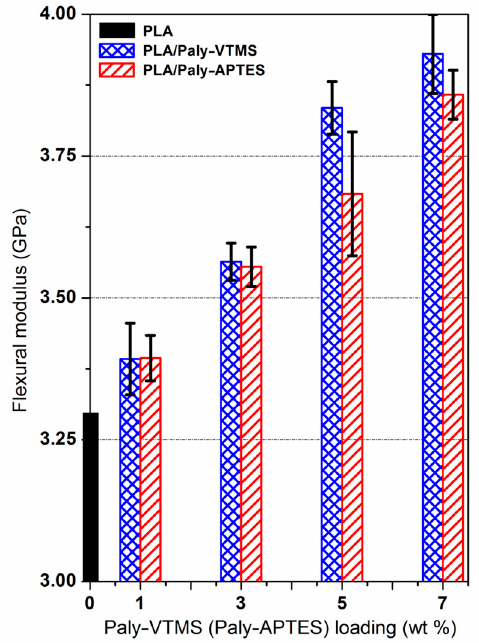
Figure 4. The flexural modulus of PLA/grafted Paly nanocomposites.